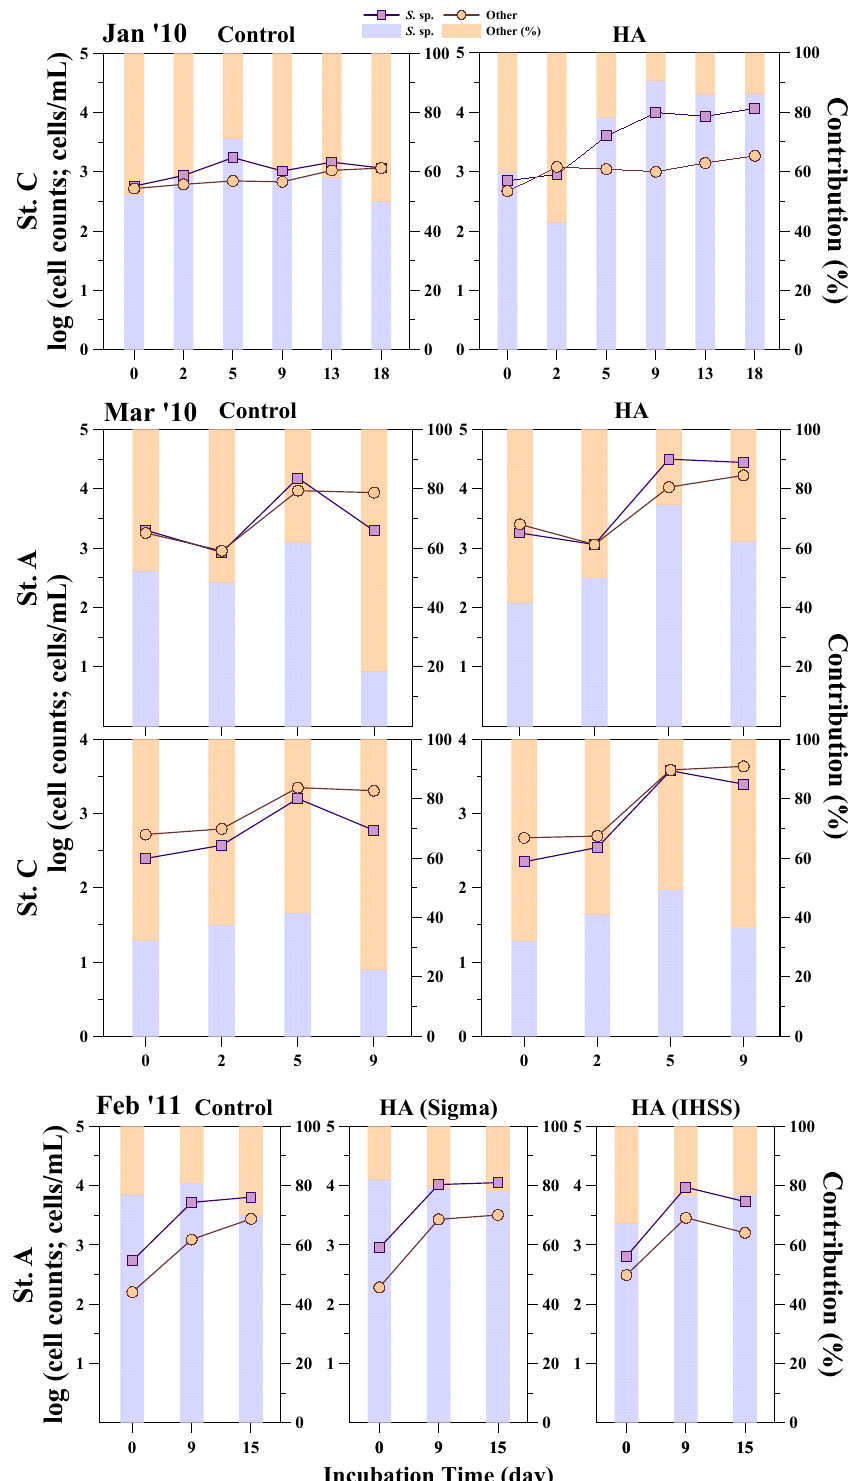
Figure 5. Size-fractionated cell abundance of a dominant species, Stephanodiscus sp. and other species in log scale and their contribution percentage (%) for treatments of control and HA addition (5 ppm) designed for the mesocosm experiments in January 2010, March 2010, and February 2011.